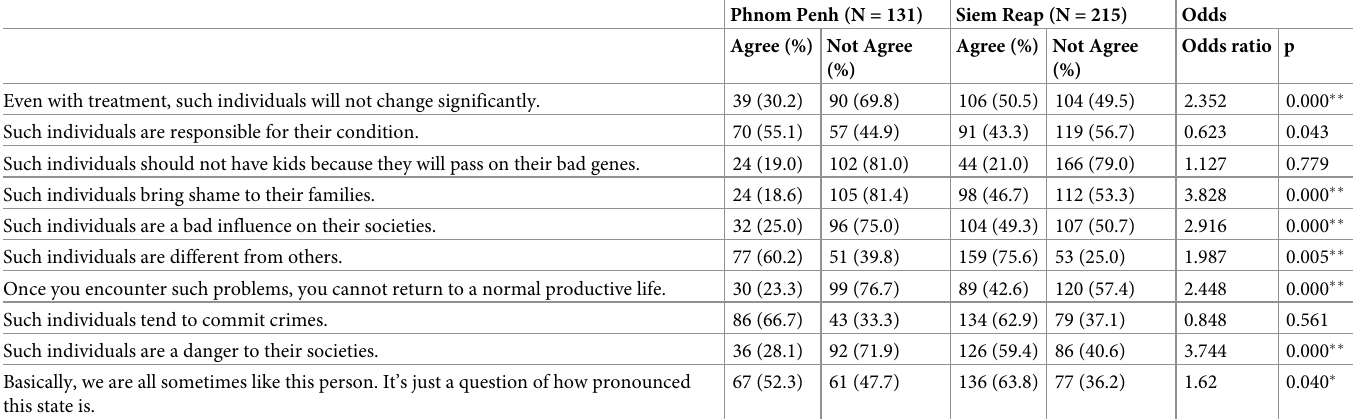
Table 3. Participants’ attitudes toward schizophrenia and